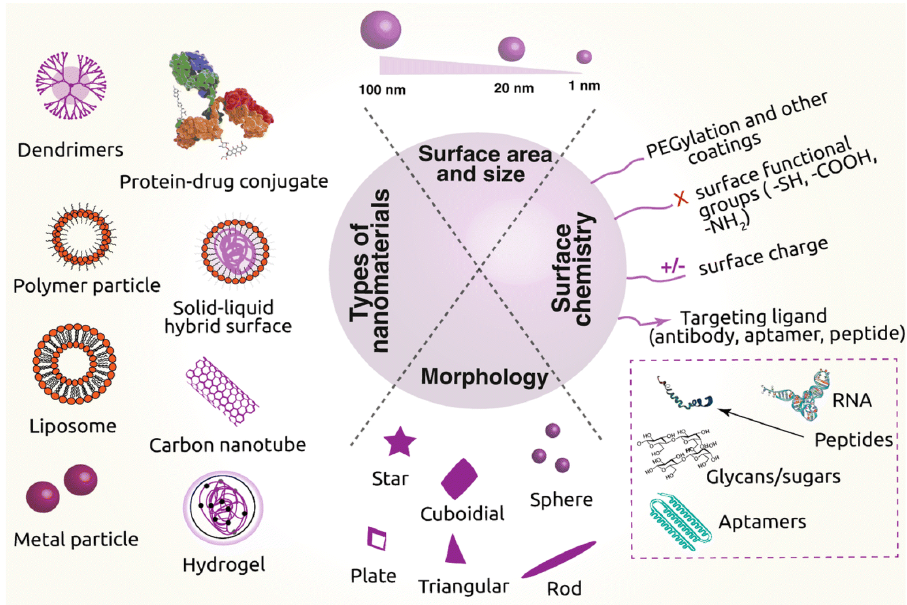
Figure 8. Current trends in drug delivery systems employing nanomaterials as drug carriers [84]. Copyright Springer Nature, 2019. Open access.